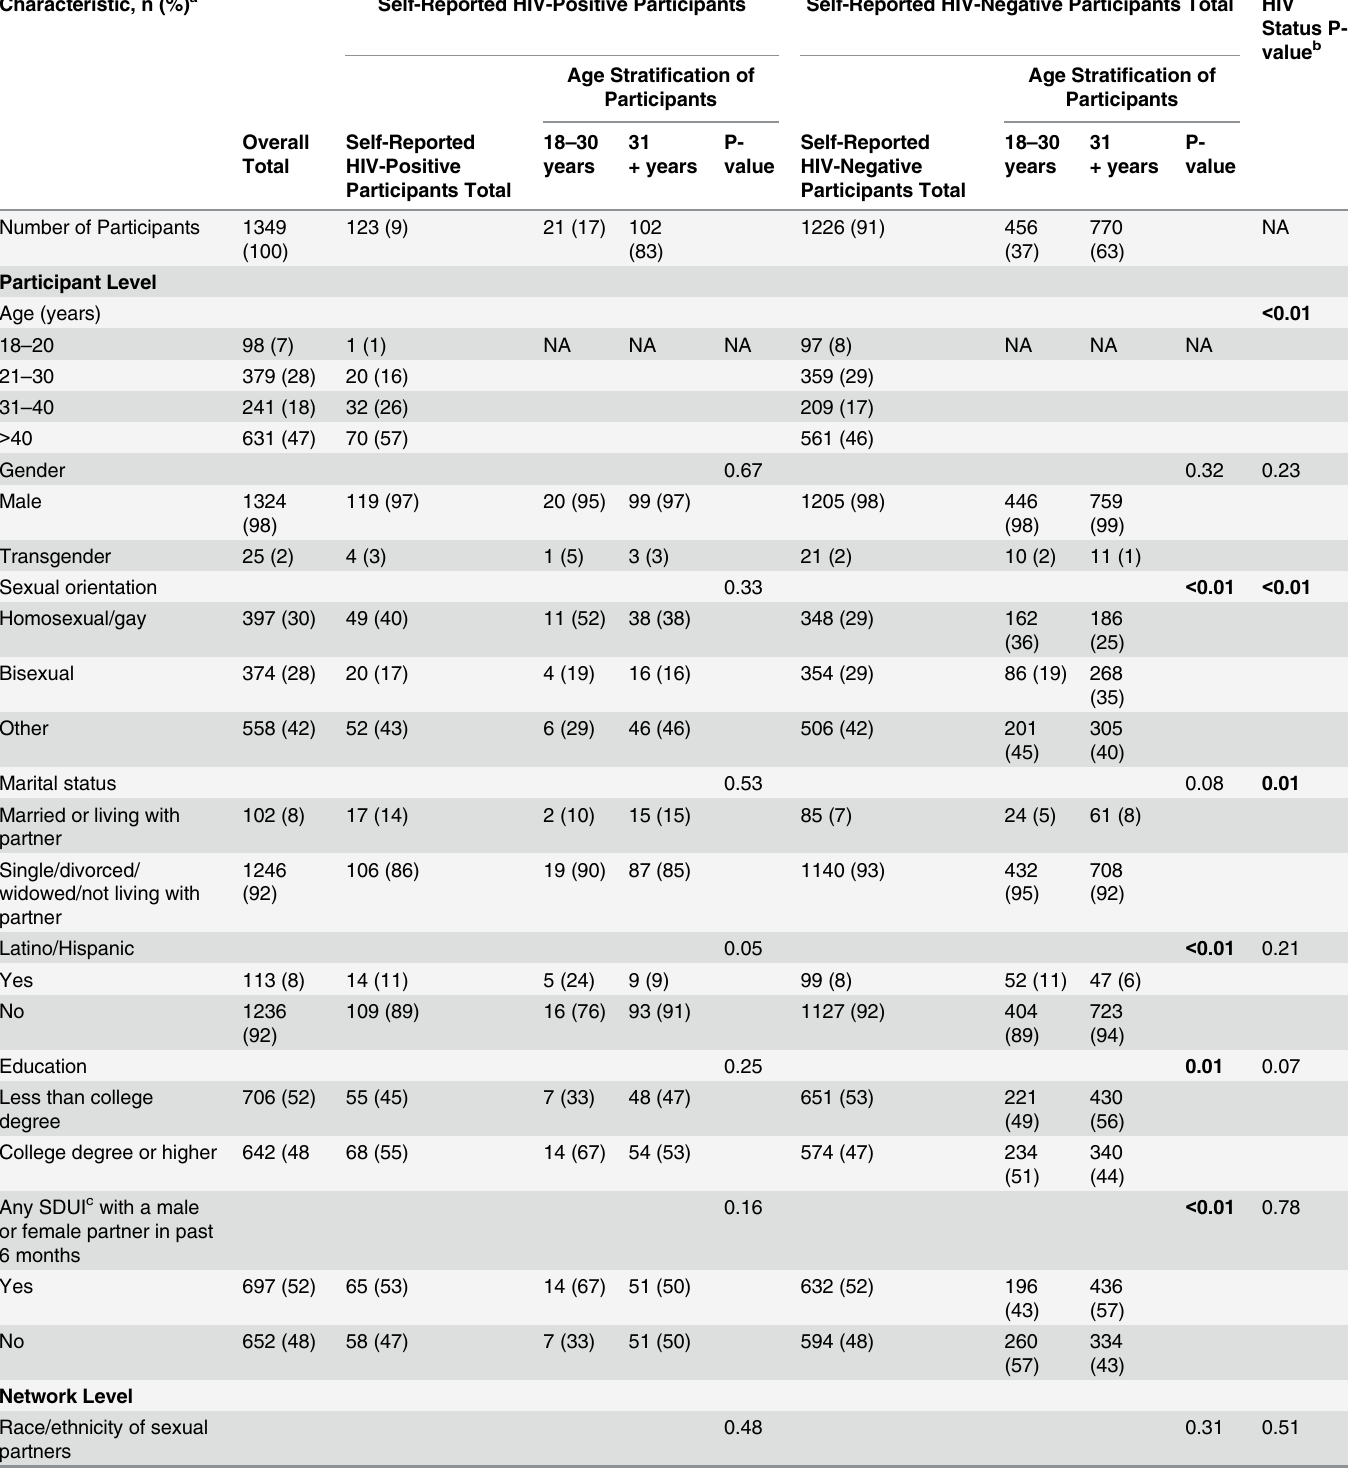
Table 1. Sociodemographics, Risk Behaviors, and Sexual Network Characteristics of Community-Recruited Black MSM Stratified by Self- Reported HIV Serostatus and Age, Participant- and Network-Level Data (N = 1,349 Participants). Characteristic, n (%)